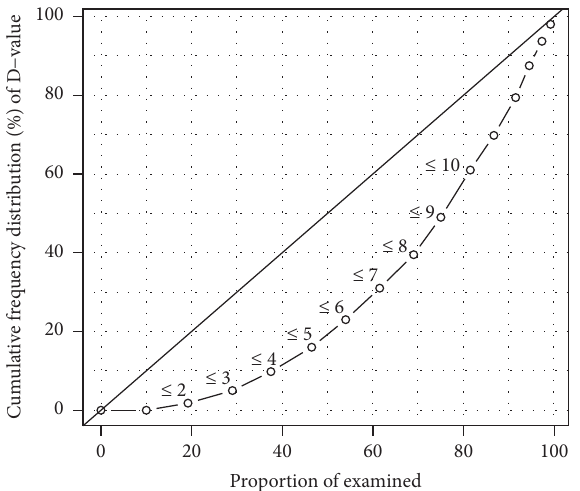
Figure 2: Lorenz curve illustrating distribution of the individuals with different restorative treatment